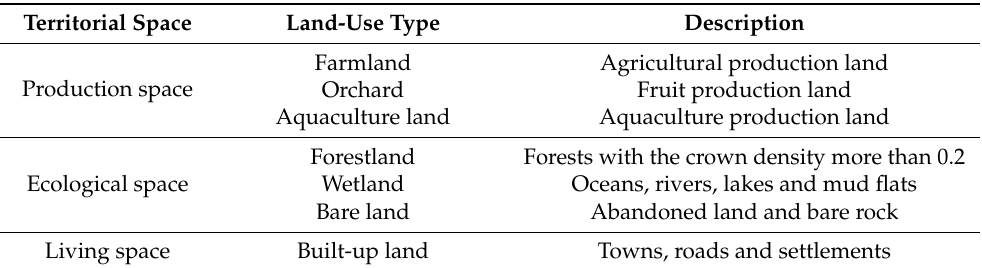
Table 1. Classification of territorial space and land-use type. Territorial